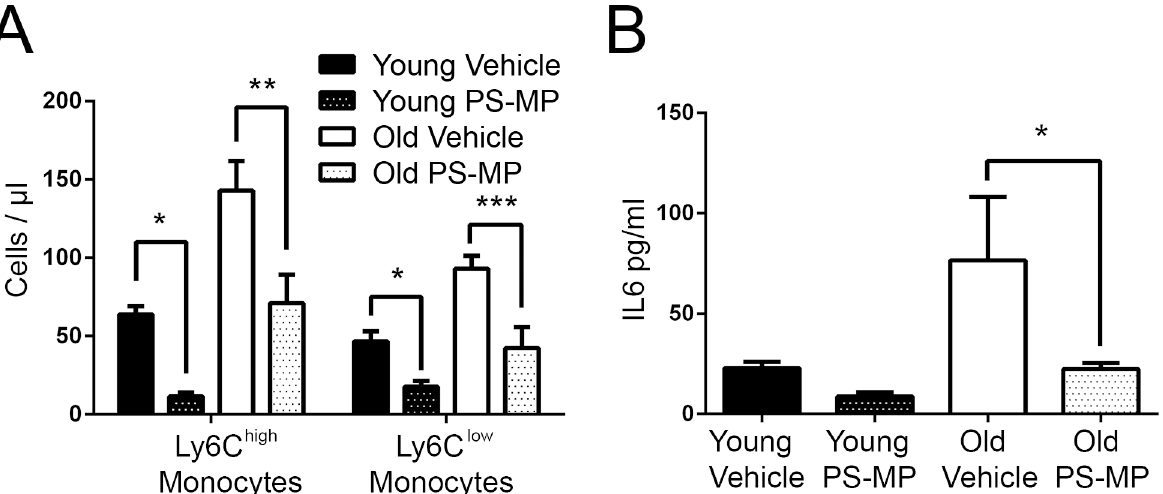
Fig 2. Ly6C high monocytes contribute to elevated levels of serum IL6 and TNF in aged mice. Young and old mice were injected with 500 nm negatively- charged polystyrene microparticles (PS-MPs) previously shown to reduce numbers of circulating Ly6C high monocytes. Circulating monocyte populations (A) and IL6 levels in whole blood (B) were quantitated after 24 hours. Statistical significance was determined by two-tailed Mann-Whitney-Wilcoxon test. * indicates p < .05, ** indicates p < 0.005, *** indicates p < 0.0005 and **** indicates p < 0.00005. (A-B) is representative of ± SEM of 5 mice from 2 independent